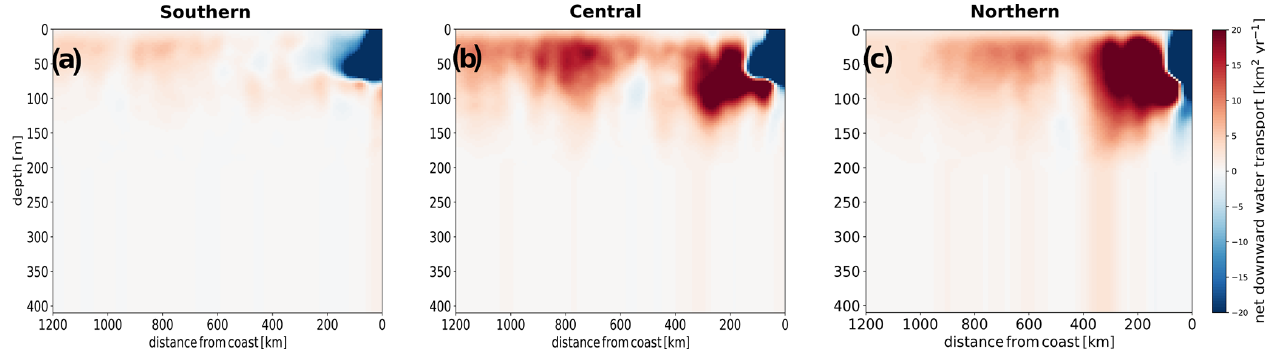
Figure 6. Meridionally integrated net downward transport of water in the (a) southern, (b) central and (c) northern subregions. All values are in km 3 of water perkm of offshore distance per year.